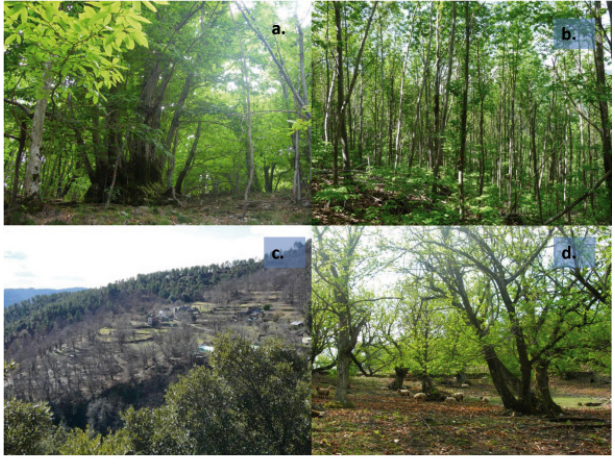
Fig. 4 . Diversity of spaces and habitats in